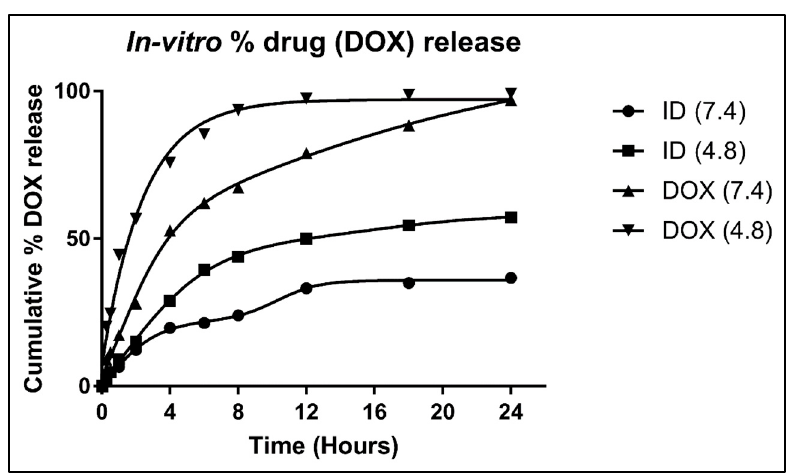
Figure 6. In vitro release profiles at pH 7.4 and pH 4.8 following Korsmeyer–Peppas